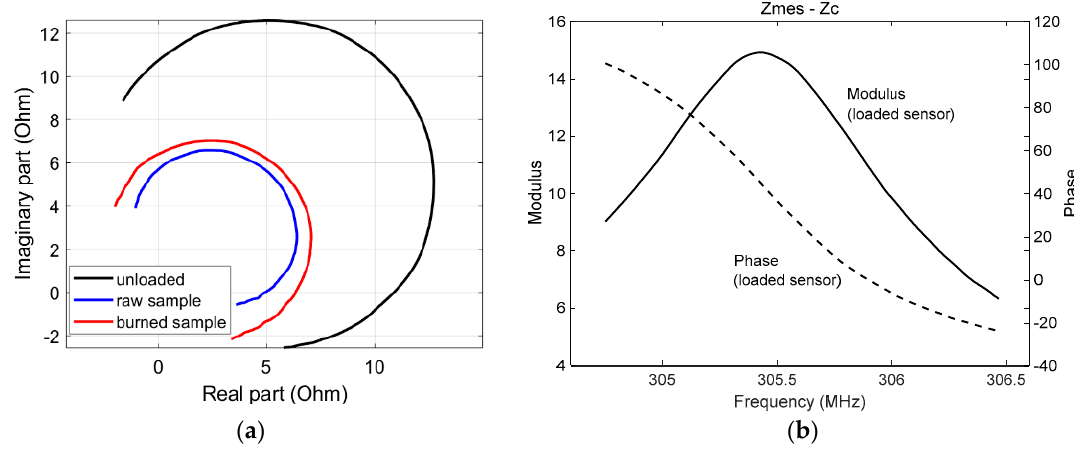
Figure 5. ( a ) Equivalent impedance Z mes − Z c obtained when the RF probe was unloaded and loaded with the raw and burned samples. The impedance changes are presented in the complex plane in a 304.6–306.4 MHz frequency bandwidth; ( b ) Modulus and phase of the equivalent impedance Z mes − Z c of the RF resonator when loaded with the sample versus frequency in a 304.6–306.4 MHz bandwidth.